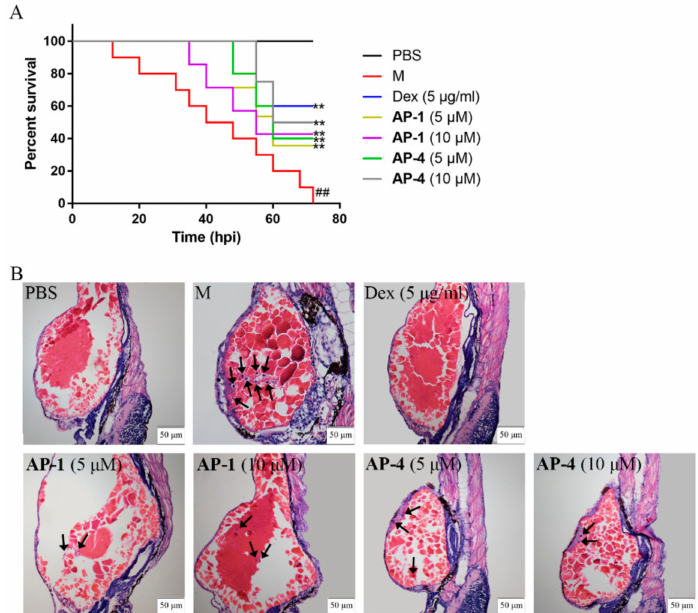
Figure 11. Protective e ff ect of AP-1 and AP-4 in LPS-induced zebrafish. ( A ) AP-1 and AP-4 reduced the mortality of zebrafish after LPS injection. The yolks of larvae were microinjected with 2 mg / mL LPS at 3 days post fertilization (dpf), and mortality was monitored for 72 h. Negative controls were microinjected with phosphate-bu ff ered saline (PBS). Data are represented as the mean of three independent experiments. ## p < 0.01 versus control group, ** p < 0.01 versus model group by one-way ANOVA with Tukey’s test. ( B ) AP-1 and AP-4 attenuated the histopathological changes in LPS-stimulated zebrafish. The zebrafish were dehydrated and embedded in para ffi n. Then, para ffi n sections (4 µ m) were stained by H&E. The black arrows represent inflammatory